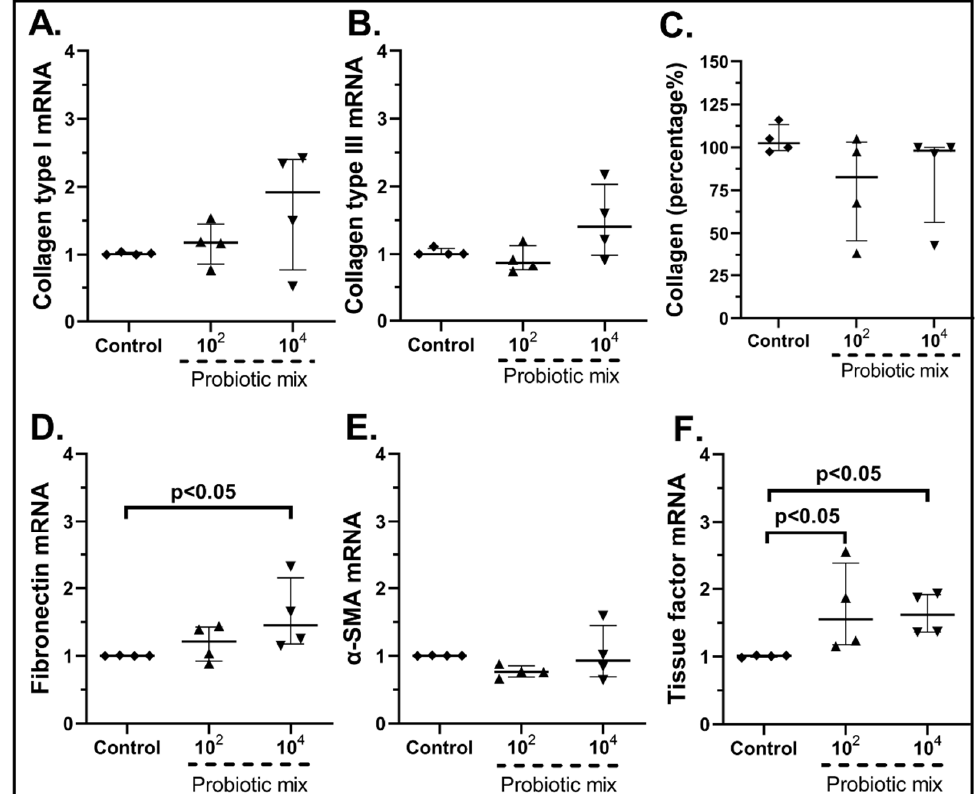
Figure 7. cSEMF mRNA expression of Collagen Type I ( A ), Collagen Type III ( B ), Fibronectin ( D ), α-SMA ( E ), Tissue factor ( F ) and Collagen secretion ( C ) after stimulation with the probiotic mix of Bifidobacterium lactis, Lactobacillus acidophilus, Lactiplantibacillus plantarum and Saccharomyces boulardii . Results are presented as median with interquartile range. N = 4.